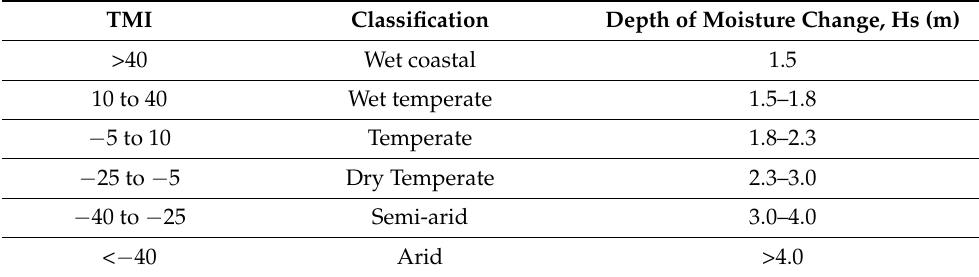
Table 4. Depth of moisture change with Thornthwaite moisture index values (after